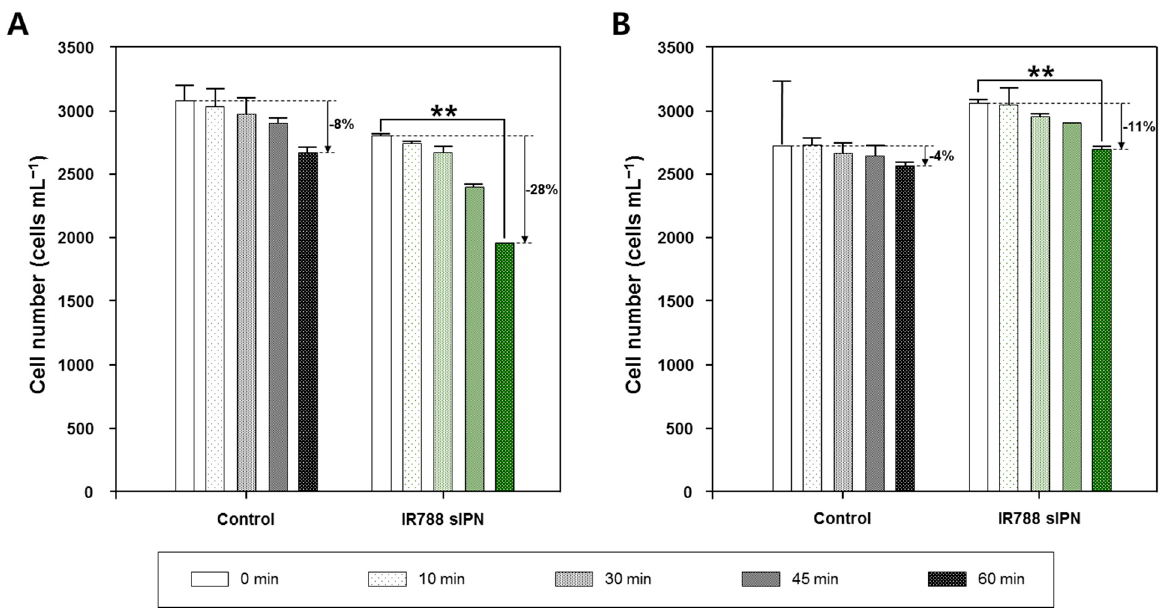
Figure 7. Change of cell number after laser irradiation under ( A ) 1.0 and ( B ) 0.5 W/cm² on Akashiwo sanguinea at different irradiation time. Noted decrease percentage is relative to each non-irradiated control (0 min). One-way ANOVA, mean ± SEM, ** p < 0.01.